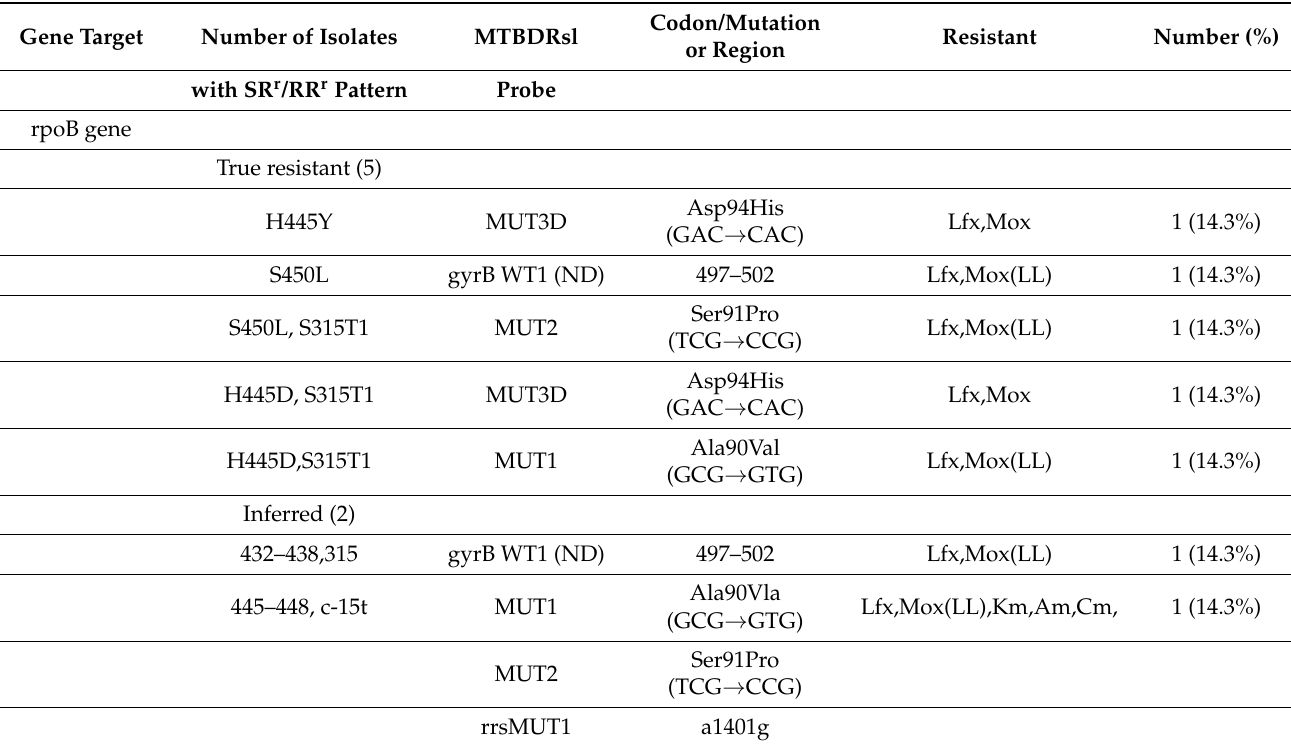
Table 1. Characteristics of gyrA and gyrB gene mutations in 51 MDR isolates.